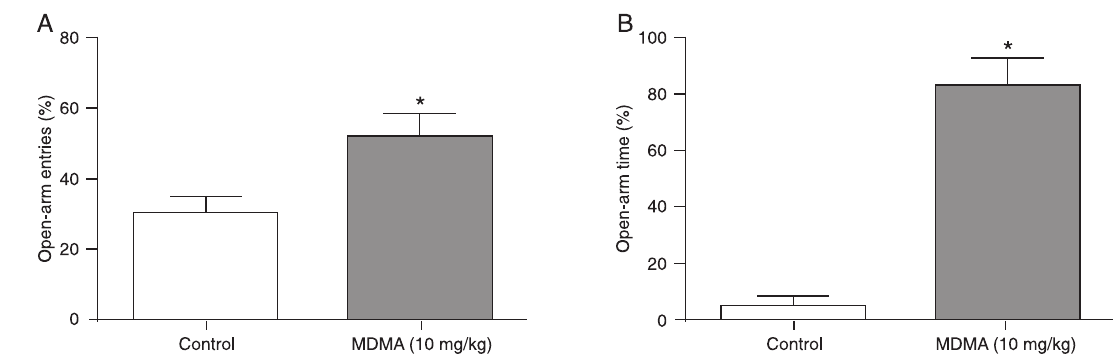
Figure 3. Behavioral effects of 3,4-methylenedioxymethamphetamine (MDMA) on BALB/c male mice in the elevated plus- maze test. A , Percent of open-arm entries and B , percent of open-arm time during the 5 min of the test. Data are reported as means ± SEM for 9-10 animals/group. *P < 0.05 compared to control (Student t -test or Mann-Whitney U-test).